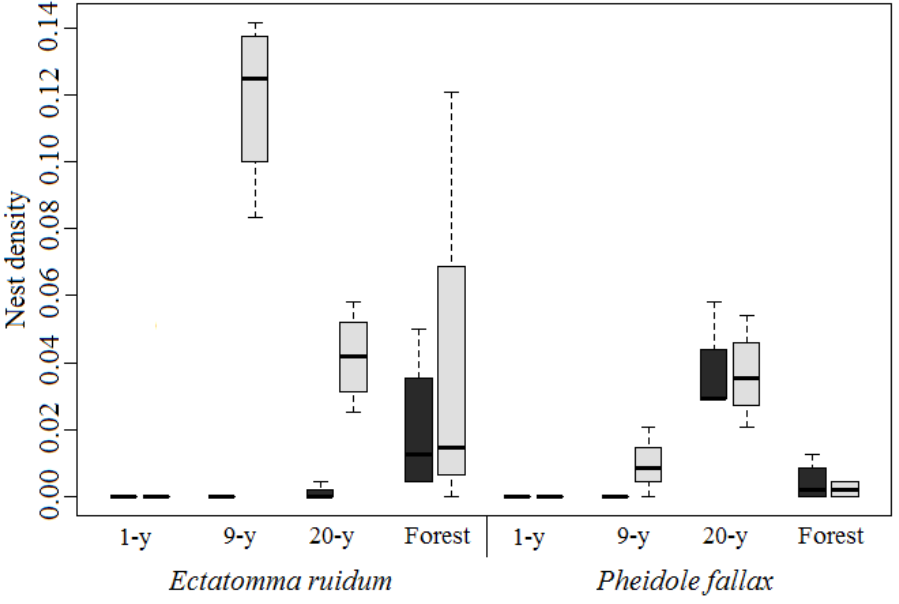
Fig 1. Box-plot of density of nest (Log 10) of E. ruidum and P. fallax in three rehabilitated sites and a forest in “El Cerrejon” mine. Black = Dry season, Gray = Wet